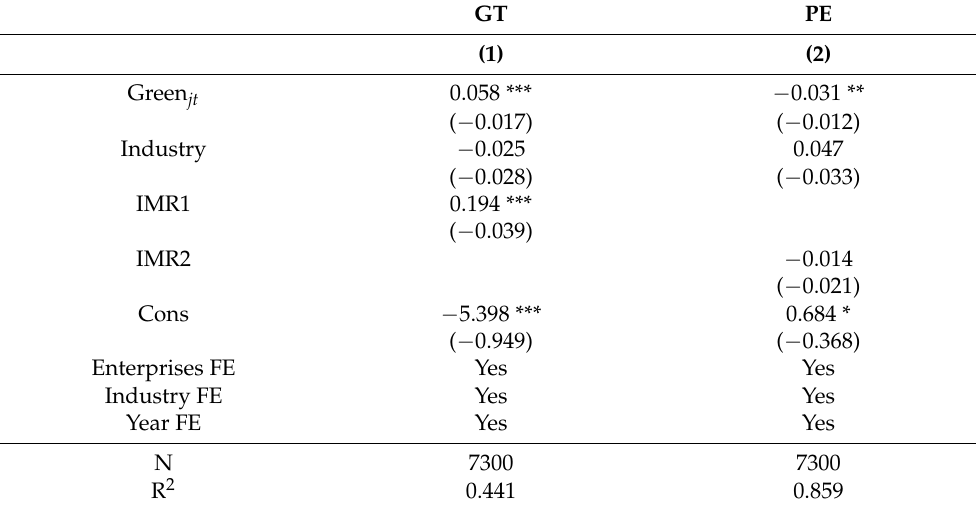
Table 6. Heckman selection